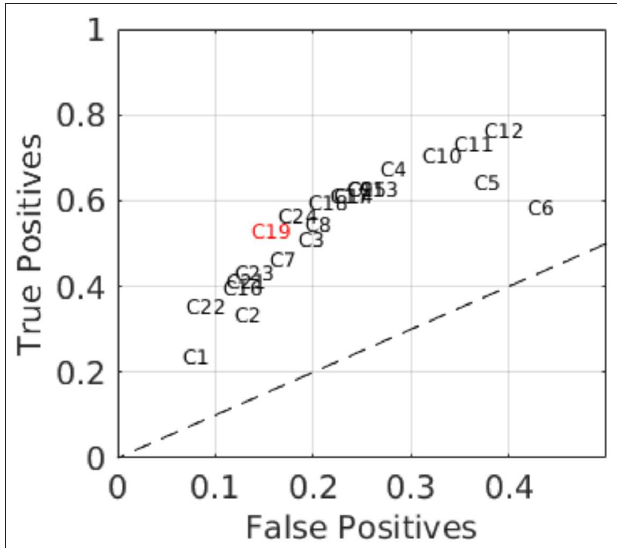
FIGURE 2 | ROC graph of the 25 algorithm runs. Each run is represented by the letter C followed by the number of the run. The chosen run is highlighted in red (C19). The dotted line is the bisector, below which any classification is random. The more to the right (left) the greater (smaller) the disagreement between automated and visual SACZ days (i.e., false positives). The more to the top (bottom) the greater (smaller) the agreement between automated and visual SACZ days (i.e., true